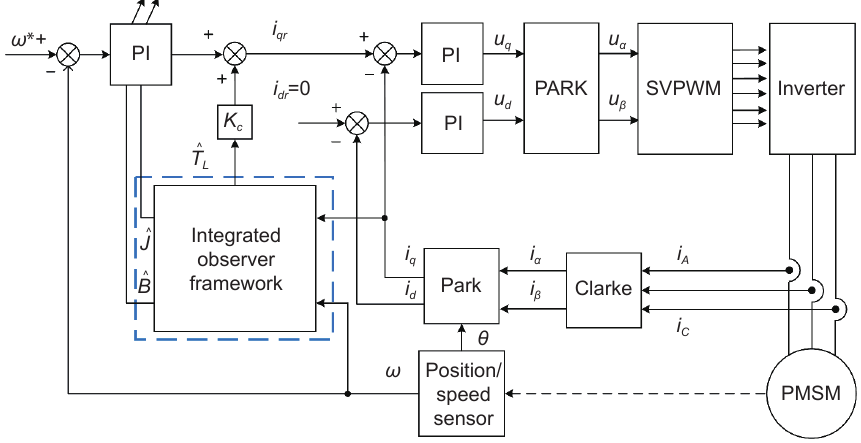
Fig. 9 System’s vector control block